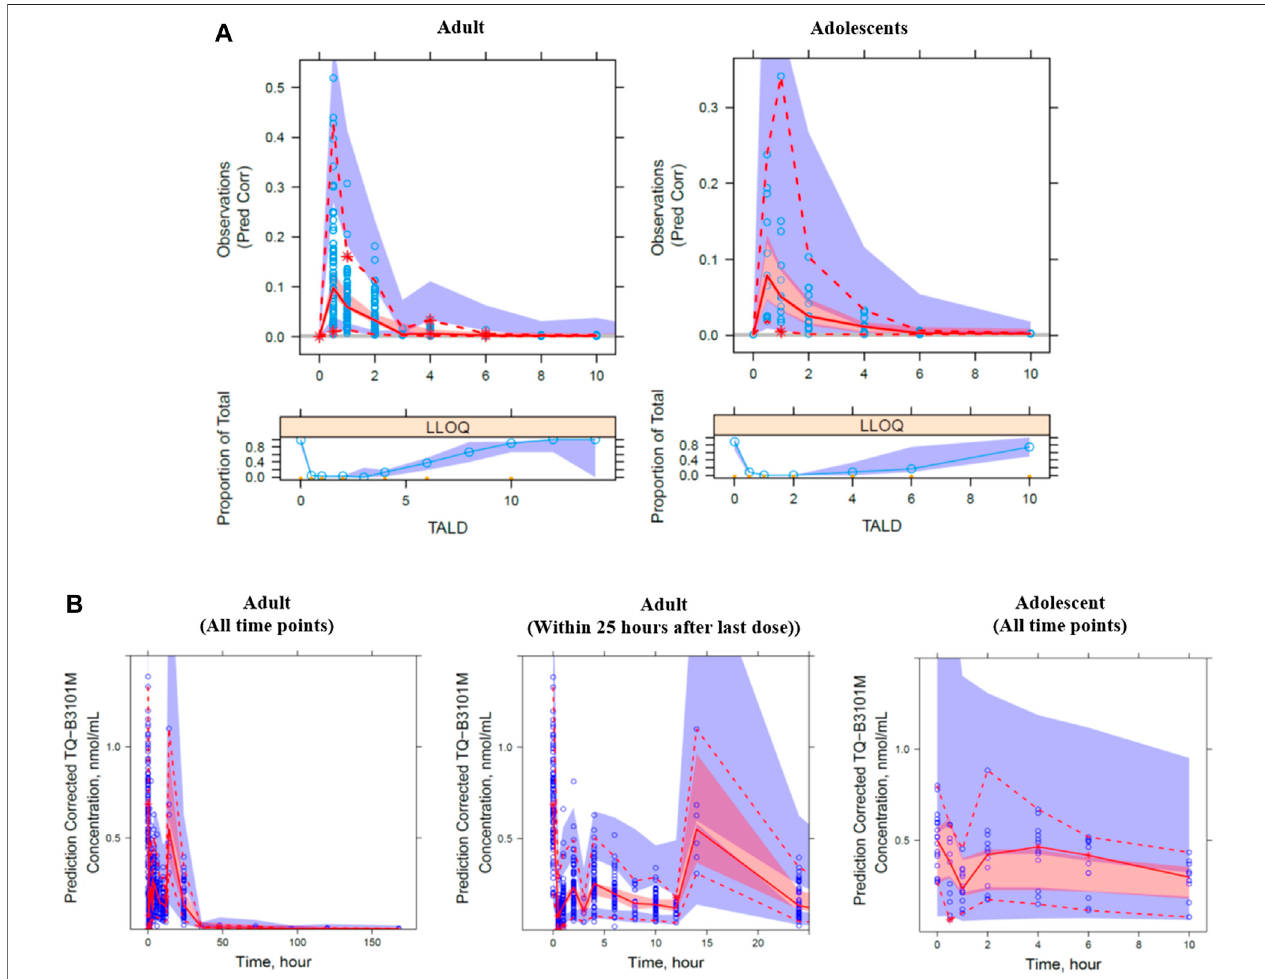
FIGURE 3 | Prediction corrected visual predictive check plot for TQ-B3101 (A) and TQ-B3101M (B) by study population. The blue circle represents the observed concentration.Thesolidanddashedlinesrepresentthemedianand2.5thand97.5thpercentilesoftheobservations.Theshadedredandblueareasrepresentthe95% con fi dence interval of the median and 2.5th and 97.5th percentiles predicted by the model, respectively. Time is nominal time after dose.